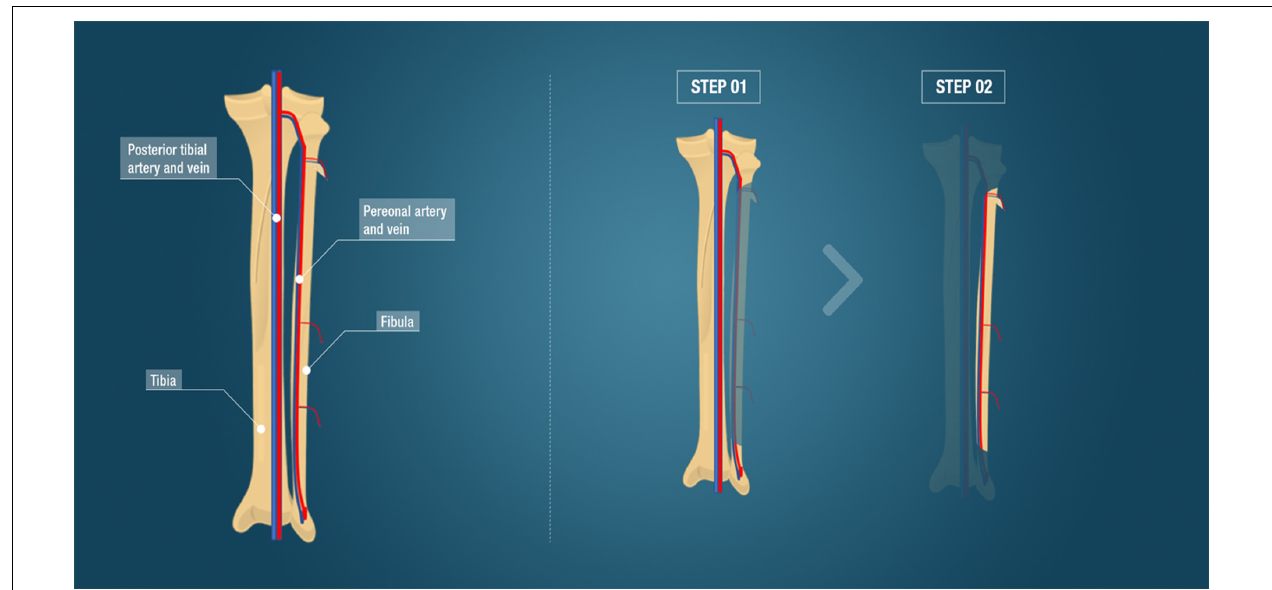
FIGURE 2 | Fibula free vascularized flap. The anatomy including the tibia, fibula and major vessels is indicated. The surgical steps comprising the fibula flap, the gold standard clinical technique for large bone defect reconstruction, is demonstrated. Step 1 illustrates the flap dissection to obtain the bone flap with its vascular pedicle. Step 2 represents the bone flap with its vascular pedicle ready to be transplanted to the bone